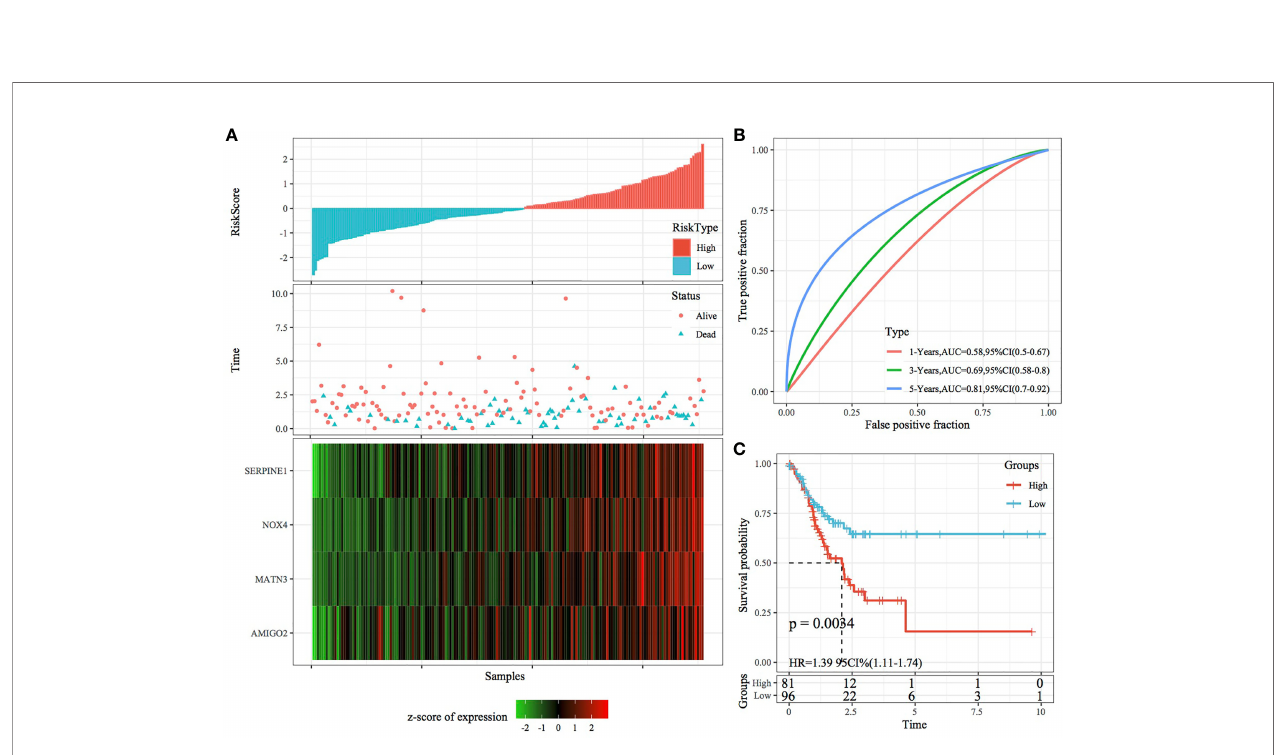
FIGURE 7 | Validation of the four-gene signature in the validation set. (A) RiskScore, survival status and the expression of four genes in TCGA validation set. (B) ROC curve and AUC of the four-gene signature. (C) KM curve demonstrating survival predicted by the four-gene signature in the validation set.